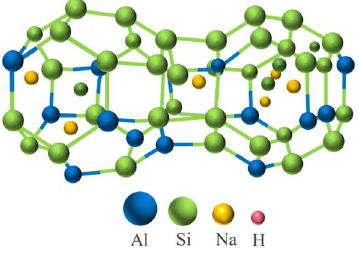
Figure 11. Three-dimensional reticulated silica-aluminate.